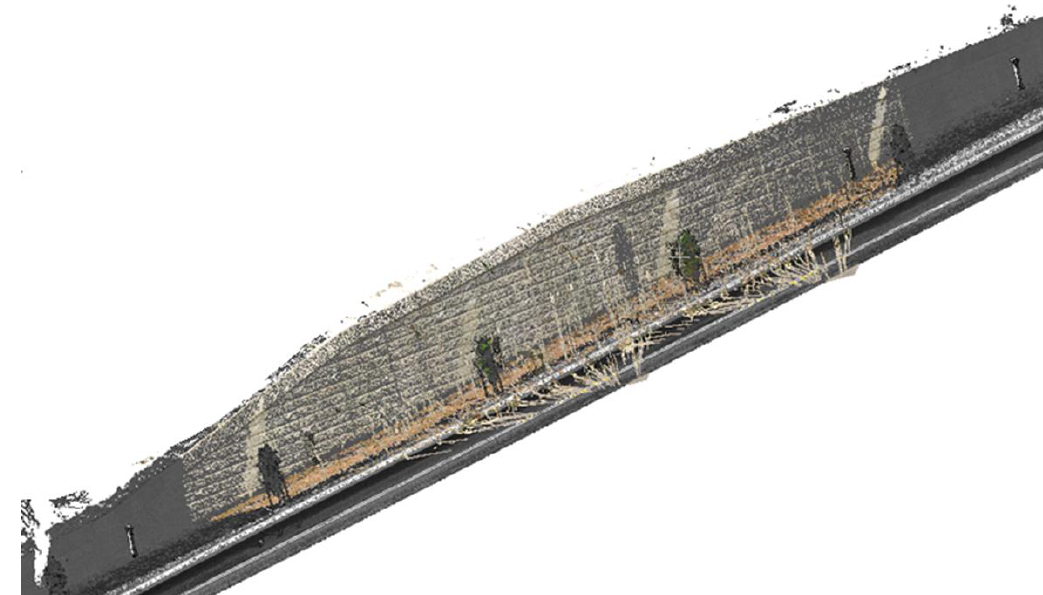
Figure 12. Point cloud registration of TLS dataset at Site-1 (colored by the RGB values from the TLS camera) and the MLS dataset (colored by intensity).